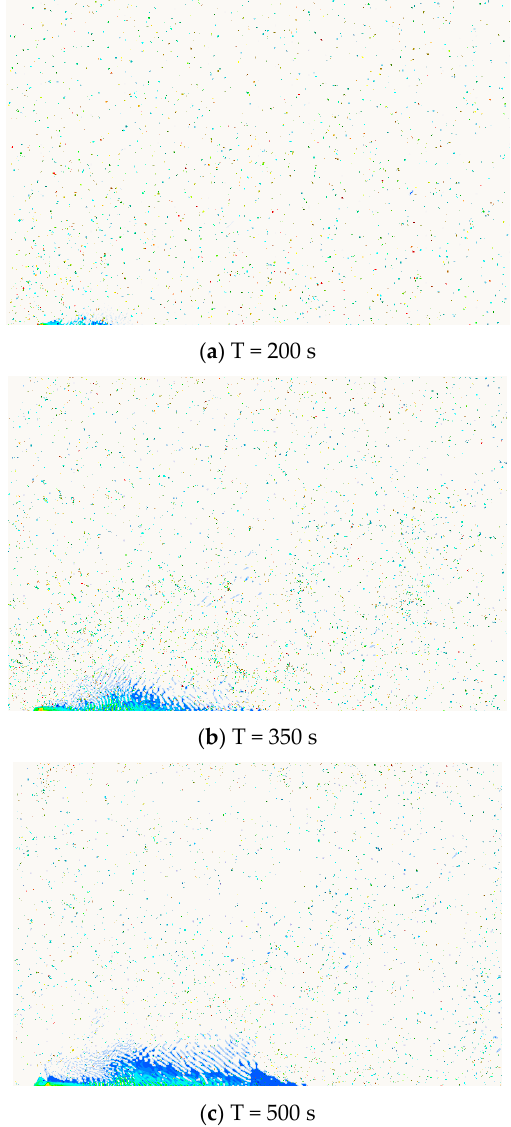
Figure 7. Oil diffusion trajectories for icy waters.